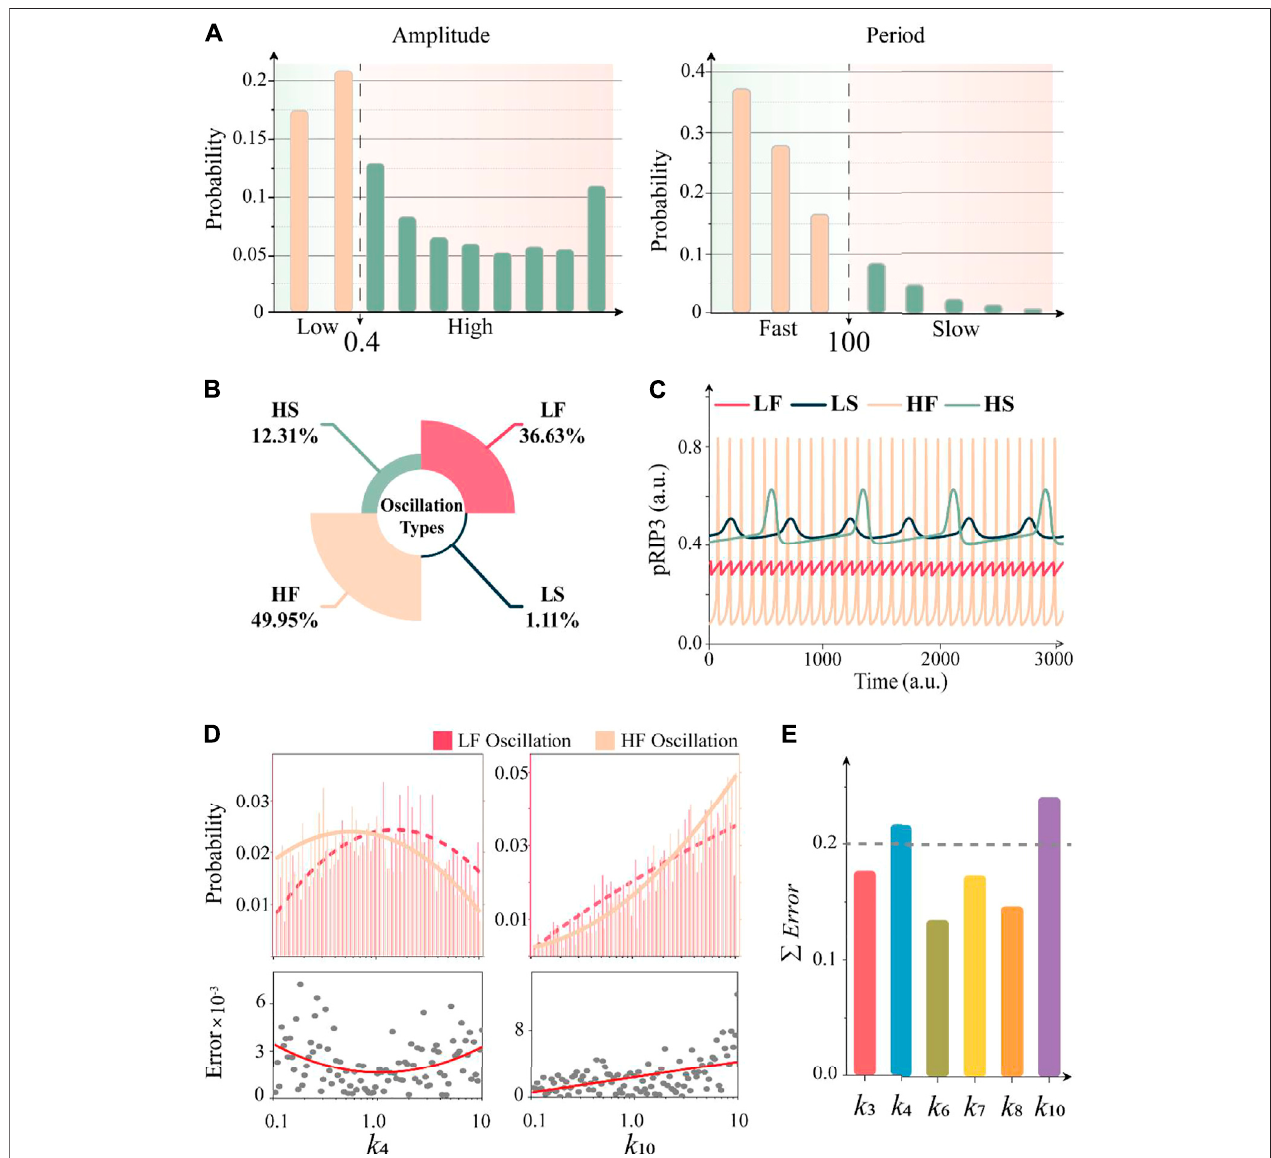
FIGURE 5 | Four types of CNS circuit oscillation behaviors. (A) The probability distribution of amplitude and period of pRIP3 oscillation in total 14,906 groups. OSC (cid:1) 0.4 and period (cid:1) 100 min are set as the boundary for amplitude and period, respectively. (B) Four typical oscillation behaviors and their corresponding probabilities. Low-Fast (LF): fast low-amplitudeoscillation,Low-Slow(LS): slow low-amplitude oscillation, High-Fast (HF): fast high-amplitudeoscillation, and High-Slow (HS):slowhigh-amplitudeoscillation. (C) Timeseriesofthefourtypicaloscillationbehaviors. (D) Comparisonofparameterdistributionofk 4 andk 10 betweenLFand HF oscillation. The upper magenta and light brown histograms represent the parameter probabilities in the sub-range, and the curves fi t the parameter distribution characteristicsofthetwooscillationbehaviorsrespectively.Thescatterdiagramofthebottompanelshowsthedistribution errorofthewholeparameter space. (E) Total differenceofdistributionsforthesixparameterswithintheunidirectionalbiasbetweenLFoscillationandHFoscillation.Ifthevalueexceeds0.2,itisde fi nedthatthereisa signi fi cant difference.